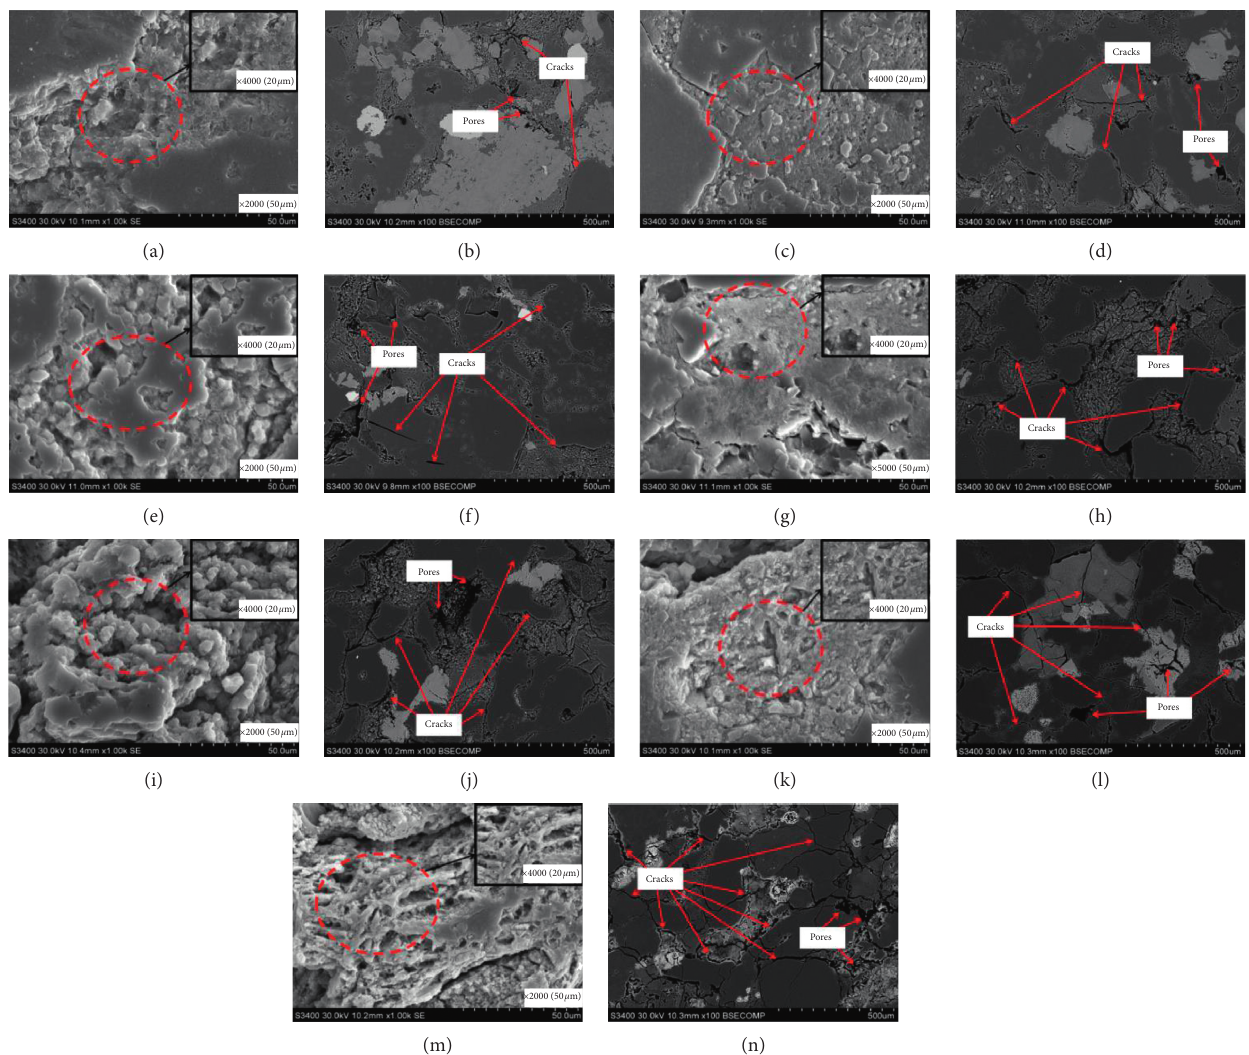
Figure 16: Microstructure characteristics of argillaceous sandstone after high temperatures treatment: (a) 20. (b) 20. (c) 100. (d) 100. (e) 200. (f) 200. (g) 400. (h) 400. (i) 600. (j) 600. (k) 800. (l) 800. (m) 1000. (n) 1000. (a, c, e, g, i, k, m) SEM results, enlarged × 2000 and × 4000; (b, d, f, h, j, l, n) EDS